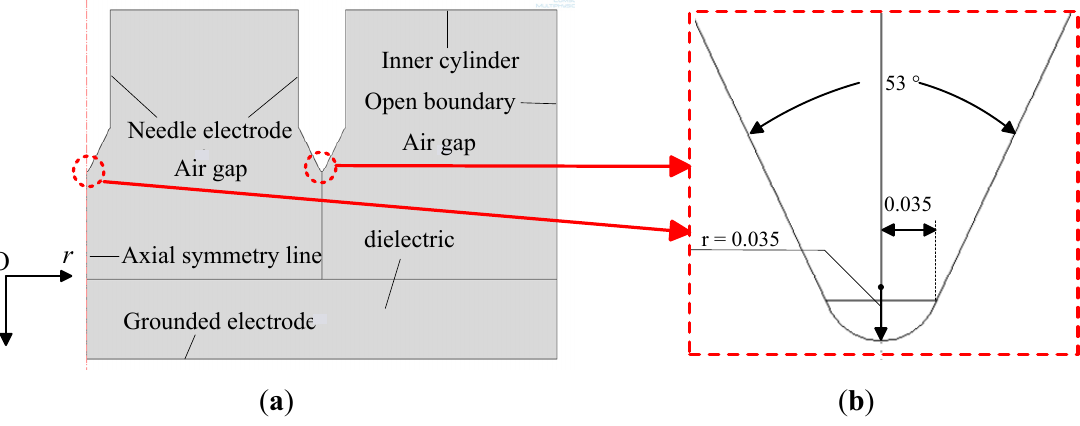
Figure 1. Geometry model in simulation and the model of the needle tip (units in milimeters). ( a ) Geometry model used in simulation; ( b ) Schematic diagram of the needle tip (units in